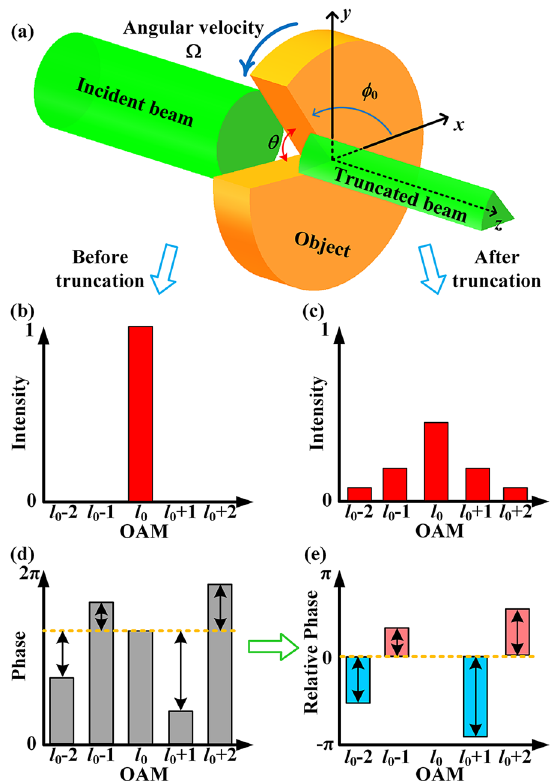
Figure 1: (a) Schematic of the OAM beam passing through a spinningobjectwhoseopeningangleis θ withangularvelocity Ω .(b) OAM intensity spectrum before truncation, and (c) after truncation. (d) OAM phase spectrum of the truncated beam, and its corresponding (e) relative phase